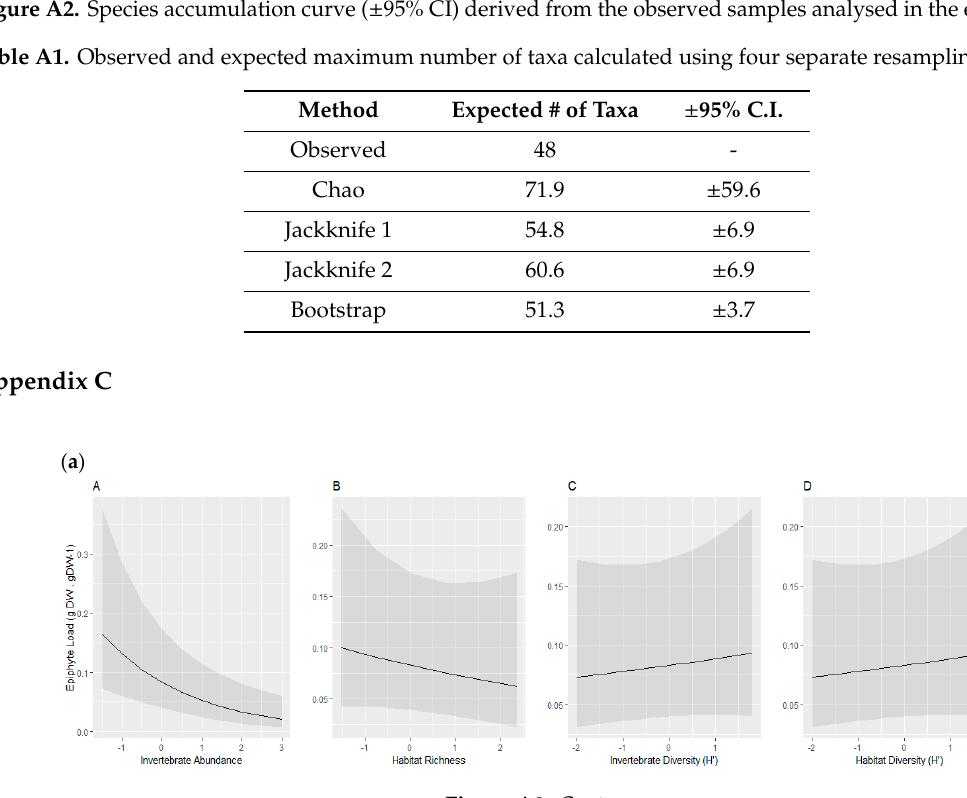
( c ) Figure A3. Partial regression plots identifying the effect of each predictor variable on ( a ) epiphyte load (gDW·gDW − 1 ), ( b ) invertebrate abundance and ( c ) invertebrate diversity when all others were